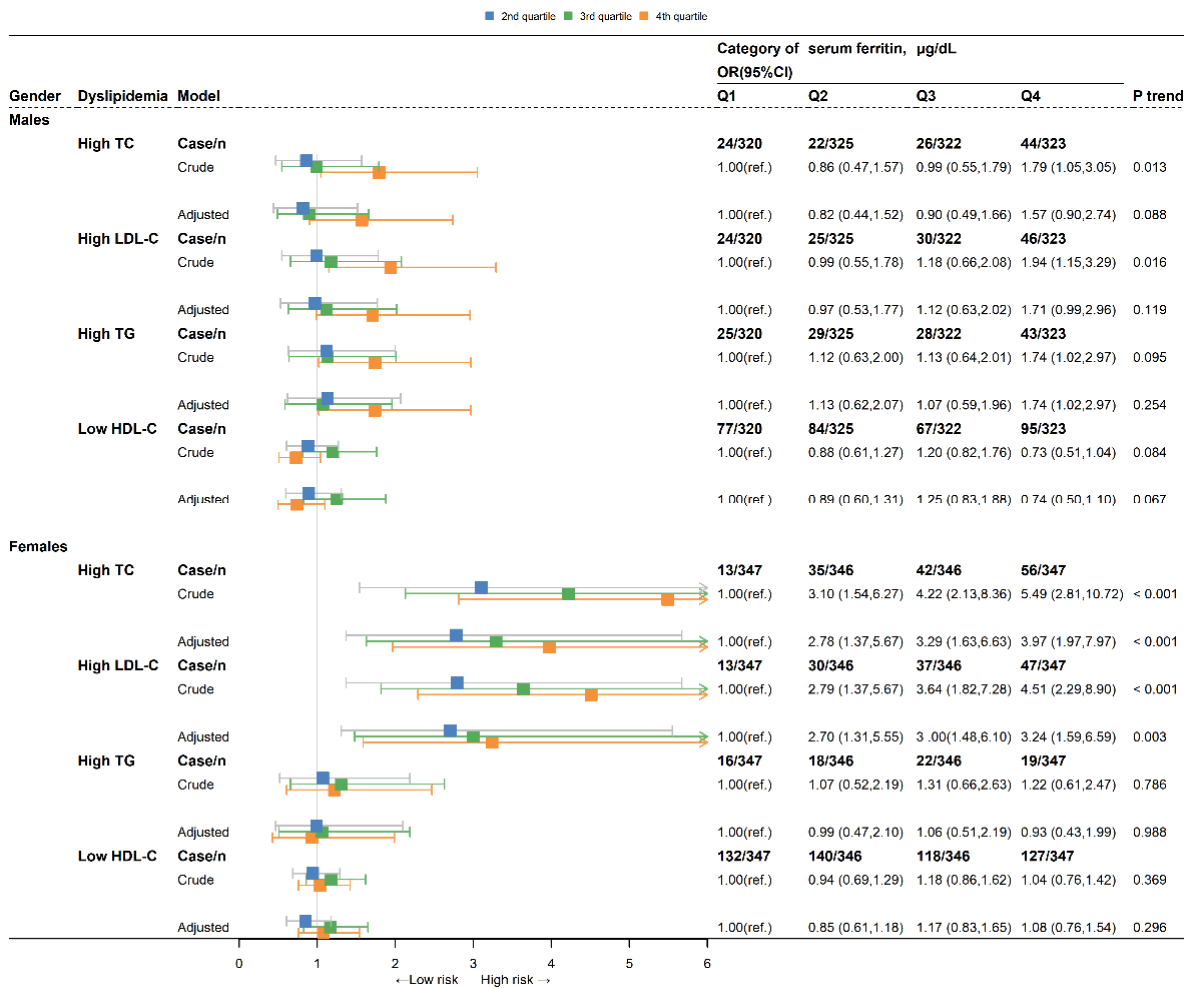
Figure 3. ORs (95% CIs) for four types of dyslipidemia according to serum ferritin in males and females. OR, odds ratio; CI, confidential intervals; Q1: 1st quartile, Q2: 2nd quartile, Q3: 3rd quartile, Q4: 4th quartile; TC, total cholesterol; LDL-C, low-density lipoprotein cholesterol; TG, triglyceride; HDL-C, high-density lipoprotein cholesterol. OR and 95% CI were obtained by multivariable logistic regression analysis (crude models). The adjusted models were adjusted for age, race, six-month time period, educational level, marital status, BMI, hypertension, smoking status, alcohol status, total daily energy intake, and total daily fat